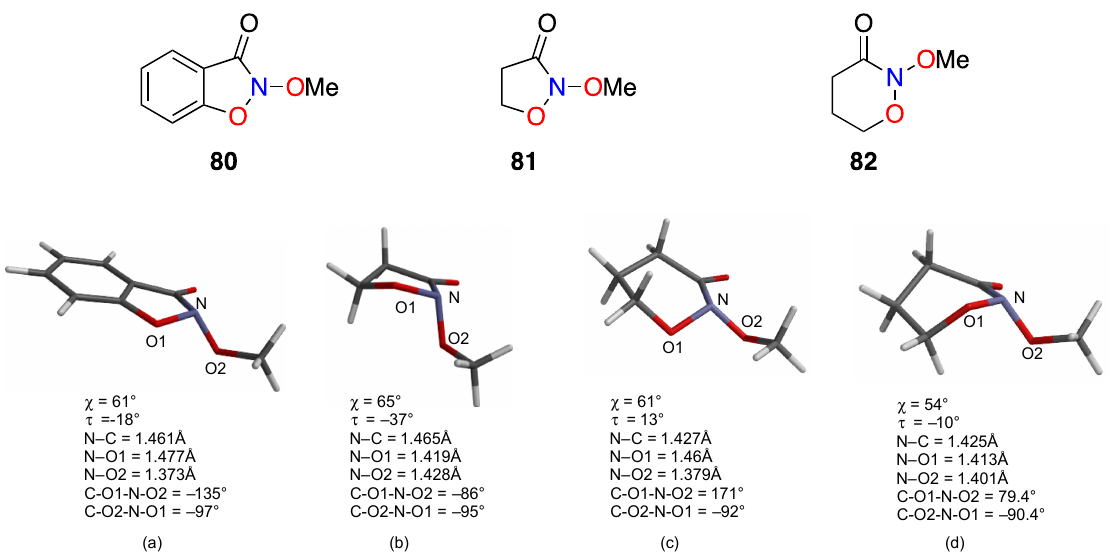
Figure 16. Ground state structures of models ( a ) N -methoxybenzisoxazolone 80 , ( b ) N -methoxy- γ - oxazinolactam 81 , and ( c ) chair and ( d ) boat N -methoxy- δ -oxazinolactam 82 .